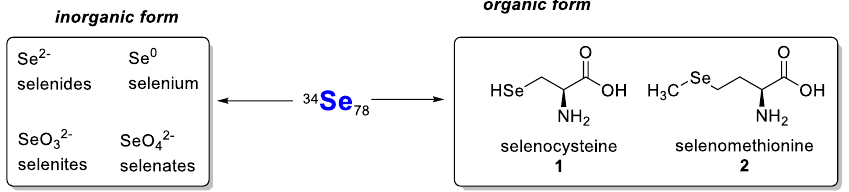
Figure 1. The most important inorganic and organic forms of selenium [11].